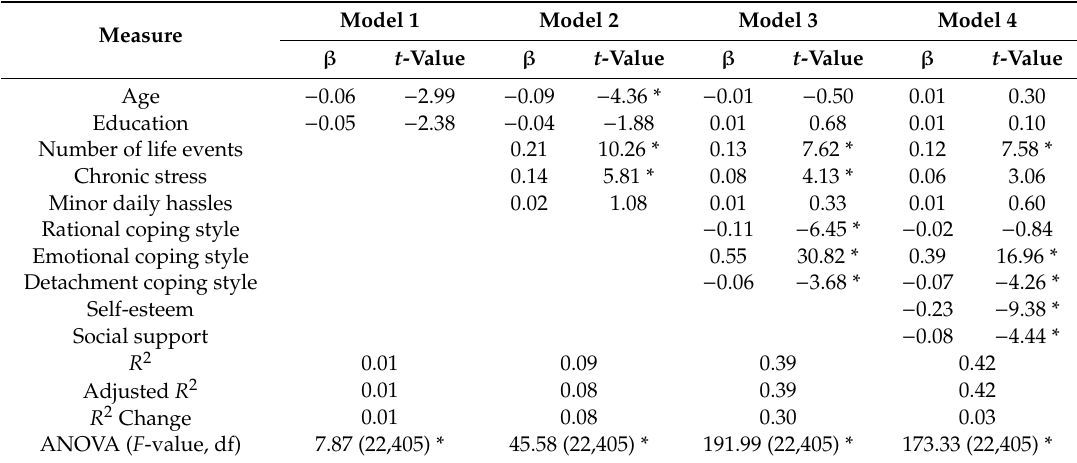
Table 3. Summary of the hierarchical regression with the psychological distress as the dependent variable for the